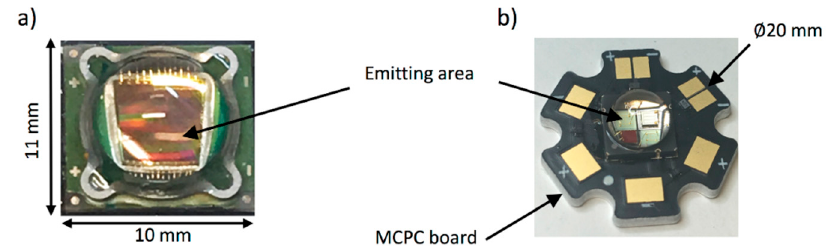
Figure 6. Photographs of high-power LEDs: ( a ) high-power LED (SST-90) with an emitting area of 9 mm 2 ; ( b ) high-power multi-wavelength LED (LZ4-00MC00, LedEngin, Inc., California, USA), composed of 4 LEDs emitting at 452, 520, 520, and 618 nm, each with a 1 mm 2 emitting area and mounted on a metal-core printed circuit (MCPC) board. These devices are encapsulated in spherical glass lenses. Reprinted with permission from High-Power Light Emitting Diodes; An Alternative Excitation Source for Photoacoustic Tomography. In: Kuniyil Ajith Singh M. (Eds) LED-Based Photoacoustic Imaging. Progress in Optical Science and Photonics, vol 7. Springer, Singapore. Copyright 2020 Springer, Singapore.